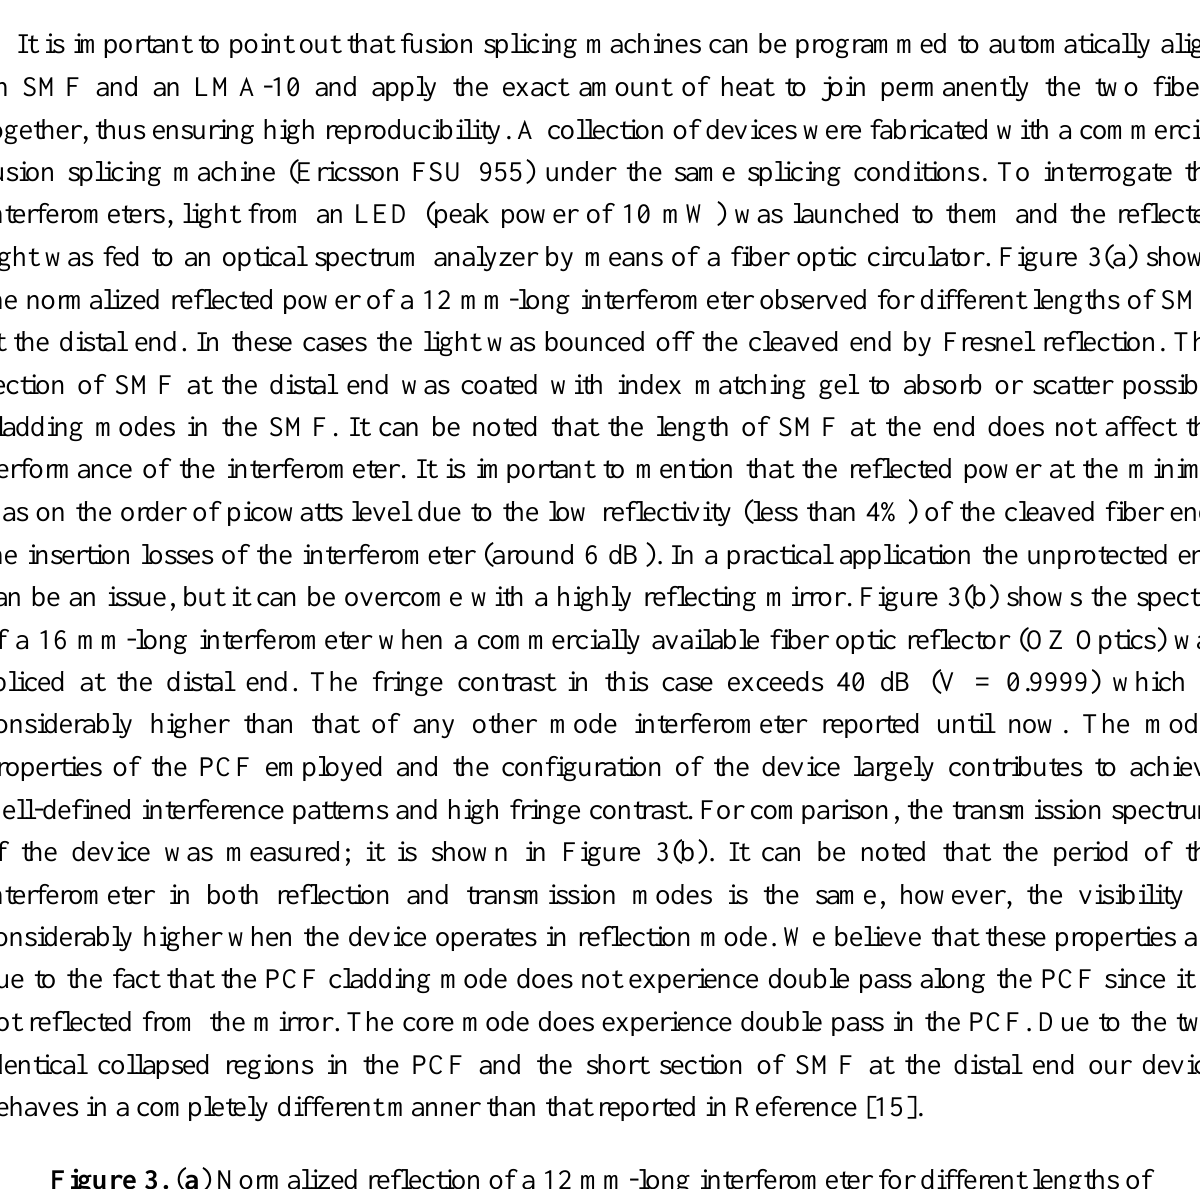
Figure 3. ( a ) Normalized reflection of a 12 mm-long interferometer for different lengths of SMF at the distal end. ( b ) Normalized transmission and reflection spectra of a 16 mm-long interferometer when a highly reflecting mirror was used. In all cases the external medium was air and the PCF was